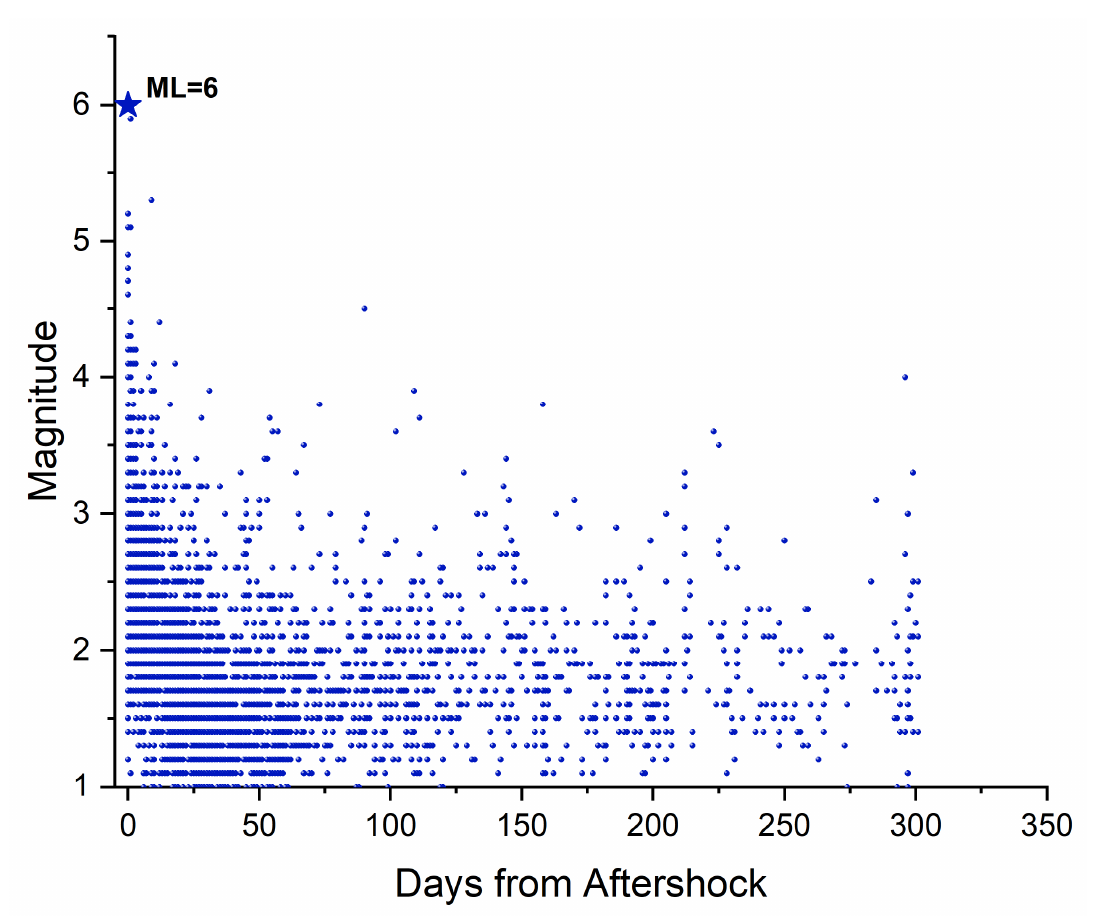
Figure 11. Distribution of magnitudes with time as a function of days from the mainshock of 3 March 2021 (10:16:08, UTC) for the 3787 records. On the x -axis is the magnitude time (days from mainshock) of each event from Elassona, Central Greece, while on the y-axis is the local magnitude (M L ).